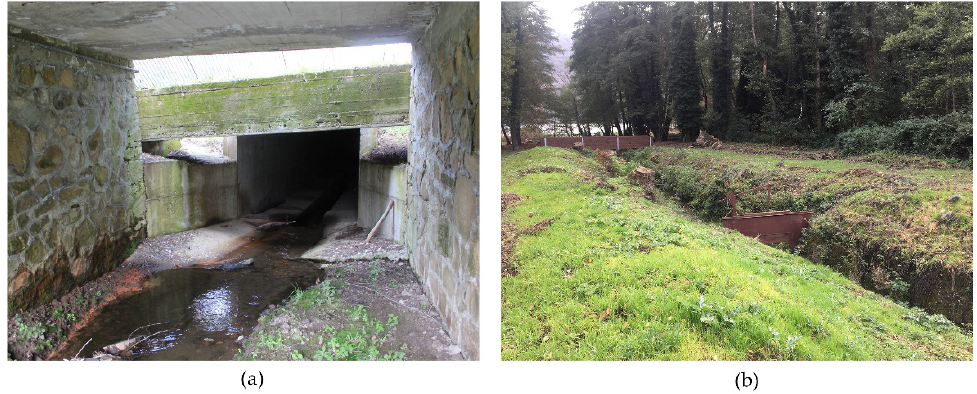
Figure 11. Constructions along the Torrente Laghi channel.